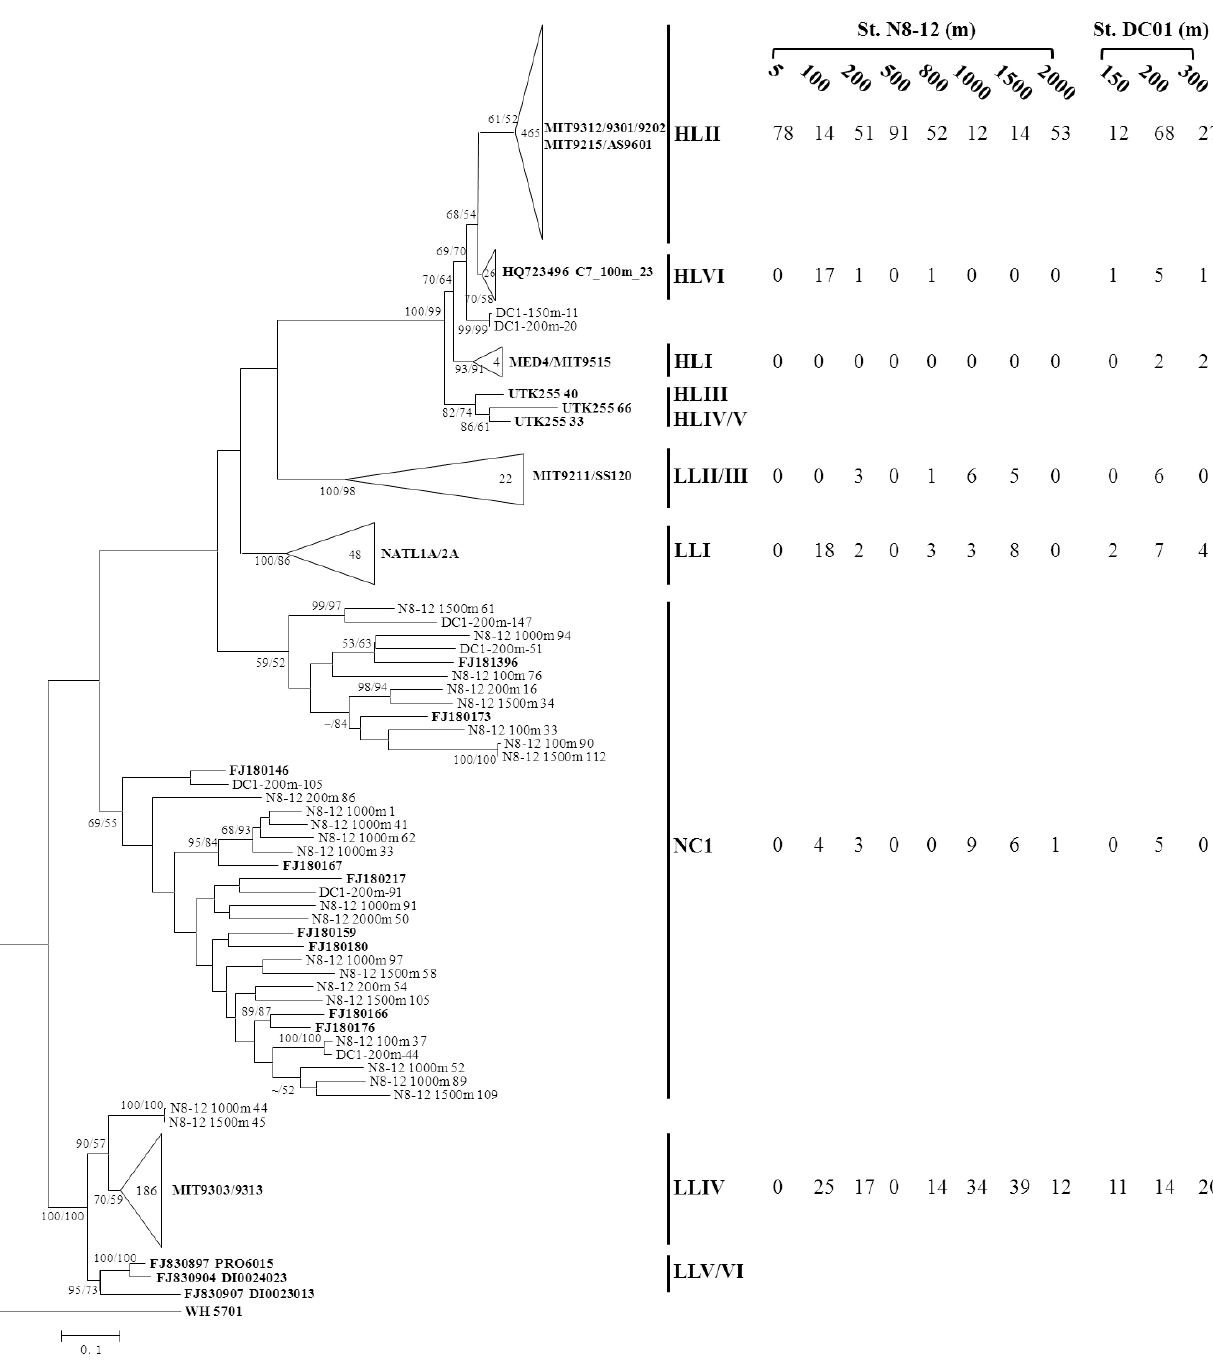
Fig. 4. Phylogenetic tree based on Prochlorococcus ITS sequences (without two tRNAs) from the western Pacific Ocean (St. N8-12 and St. DC01) showing that both high-light and low-light ecotypes of Prochlorococcus were present in samples from the aphotic waters. Support values, with 1000/100 replicates for NJ andML analyses, were shown in the order of NJ/ML at nodes (values lower than 50% are not shown). The numbers of environmental sequences recovered in this research were shown in the triangles. Cultivated strains and environmental sequences from previous studies were shown in bold. Scale bar indicates 0.01 nucleotide substitutions per site. The numbers of sequences of each ecotype are